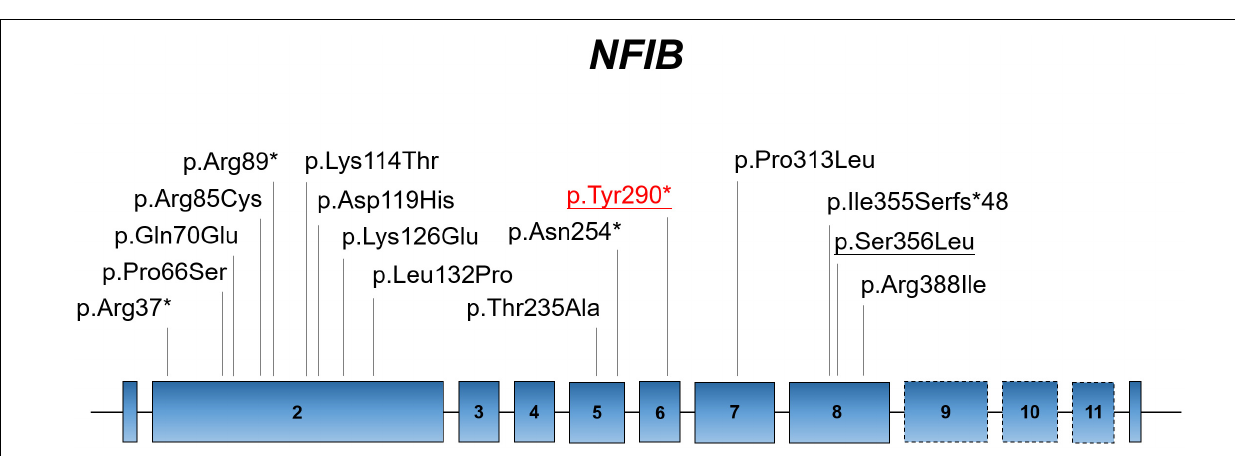
deficiency. Currently, only 12 missense/non-sense and 2 small deletion/insertion variants of NFIB have been recorded in the Human Gene Mutation Database (HGMD; data retrieved in January 2022) ( Figure 2 ). Here, we identified a novel